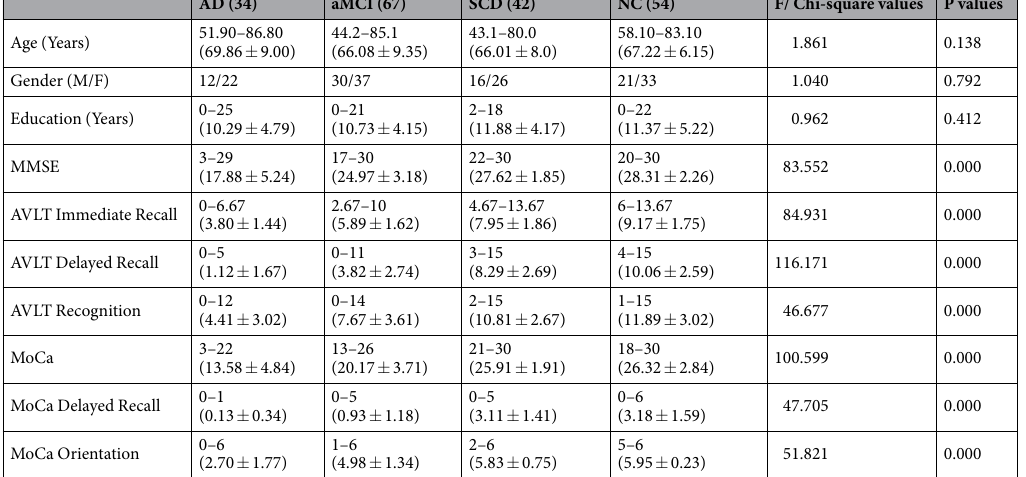
Table 2. Demographic information and behavioral measurements for AD, aMCI, SCD and NC. AD, Alzheimer’s Disease; aMCI, amnestic Mild cognitive impairment; SCD, subjective cognitive decline; NC, cognitively normal subjects; MMSE, Mini-mental state examination; AVLT, Auditory verbal learning test; MoCA, Montreal cognitive assessment. Differences among the samples were tested with ANOVAs (p < 0.05) with LSD or Dunnett’s T3 post hoc